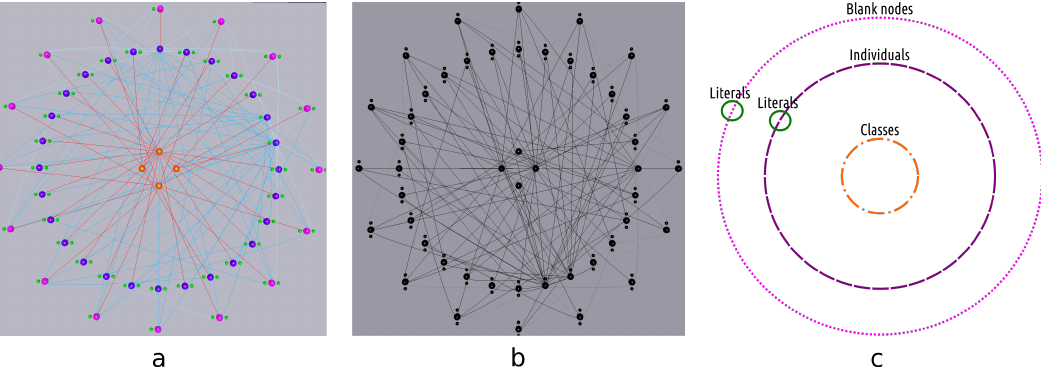
Figure 3. The classification of RDF terms among blank nodes, individuals, classes or literals as well as data and object properties, bound to using colors provide a more intuitive visualization ( a ), if compared to a monochrome one ( b ), the drawing strategy adopted by Tarsier ( c )